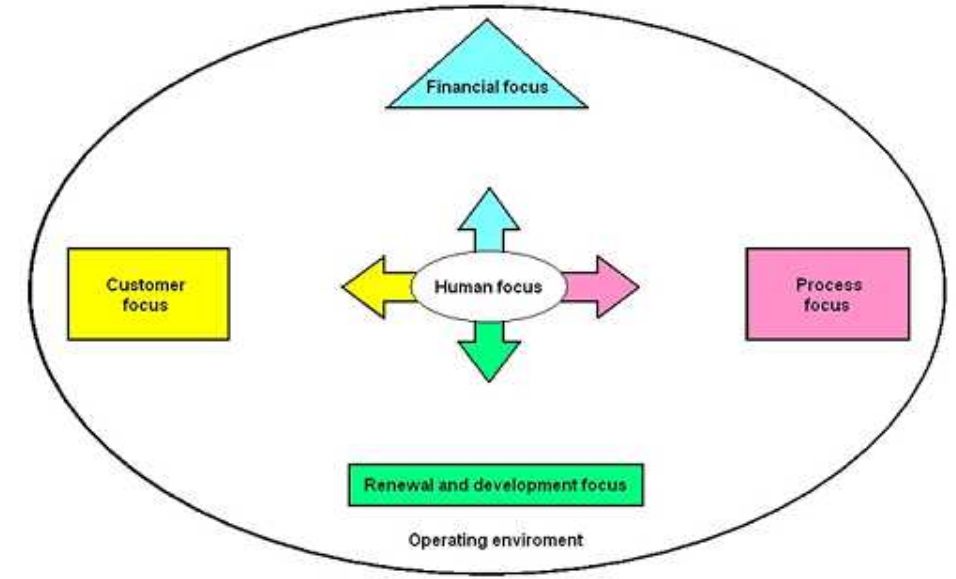
Figure 4 Intellectual capital management framework (Source: Huang